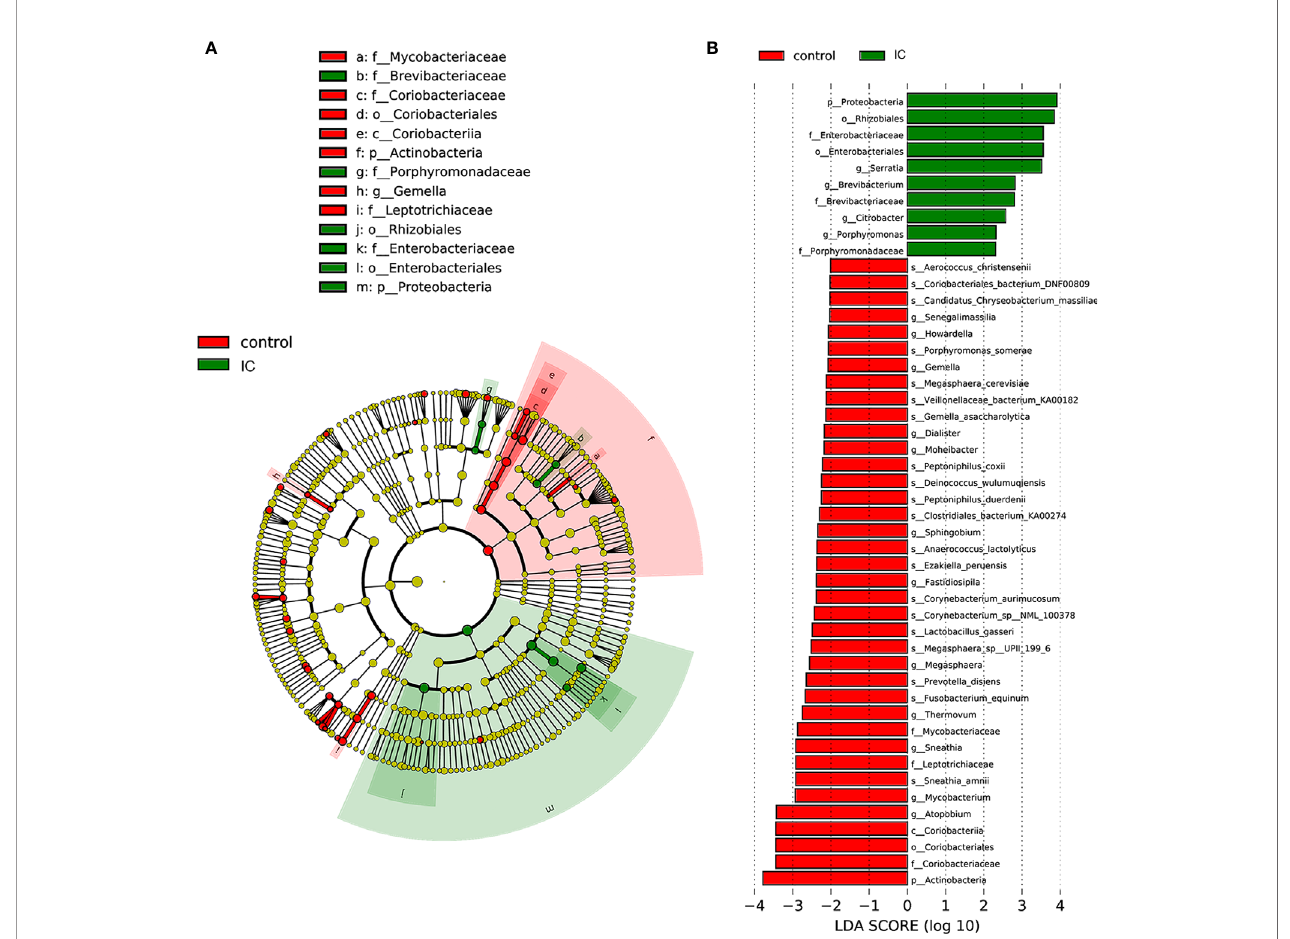
FIGURE 2 | LefSe identi fi ed the most differential genera between IC patients and controls. Cladogram (A) ; Histograms (B)